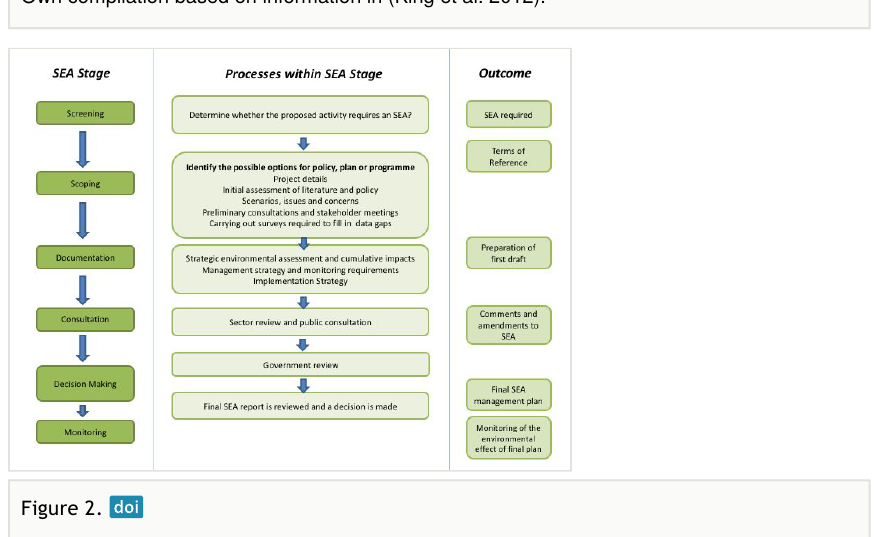
Figure 1. Data use within the EIA process Own compilation based on information in (King et al. 2012).